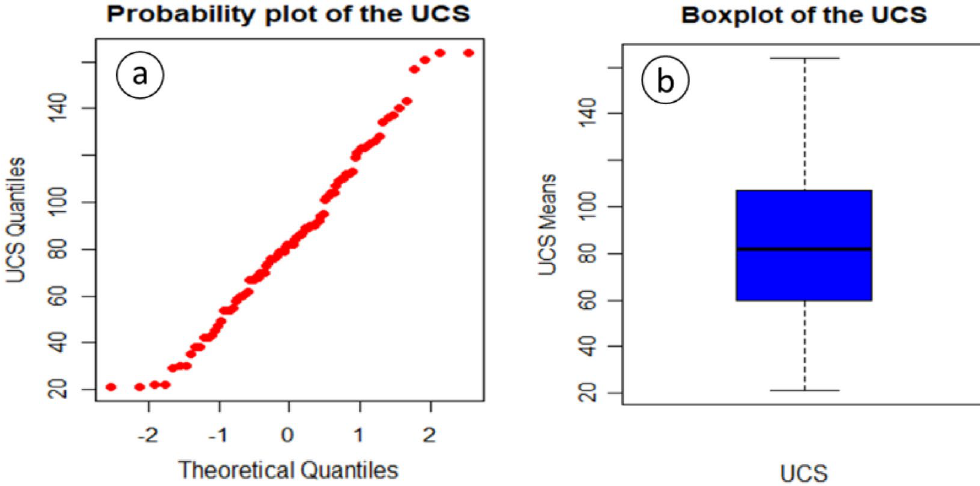
Figure 2. ( a ) Normal probability of the UCS, ( b ) boxplot of the UCS.